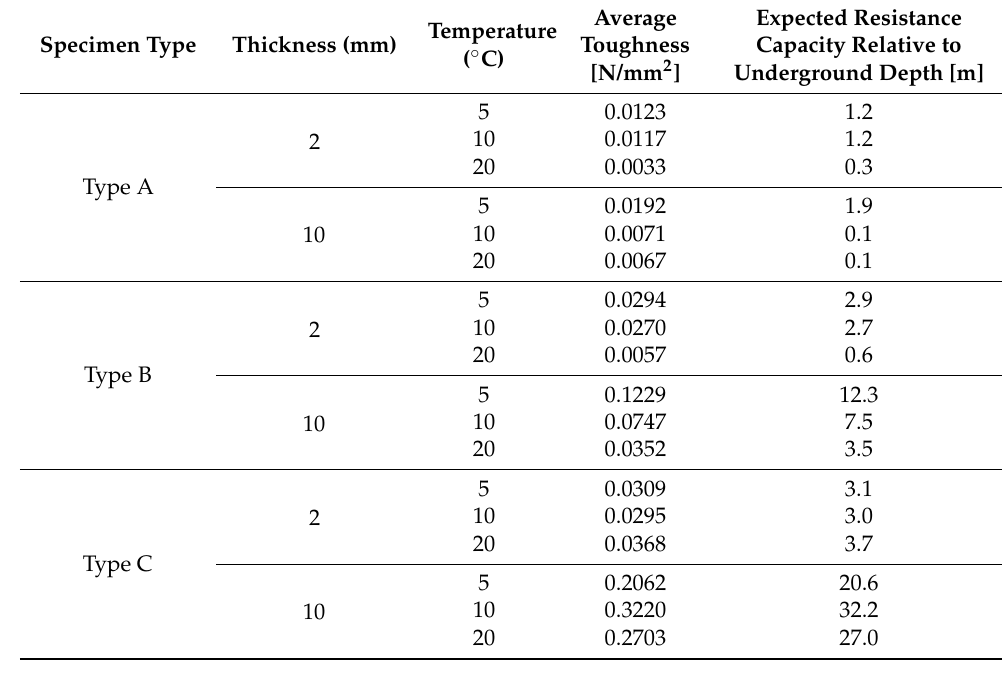
Table 6. Comprehensive toughness of specimen types in accordance with thickness and temperature.